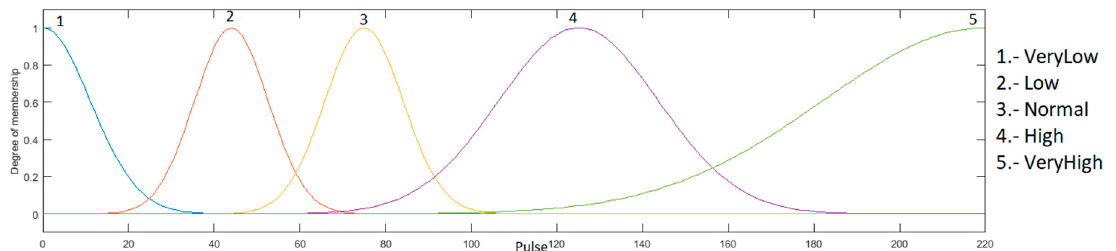
Figure 22. Optimized input age with Gaussian MFs.